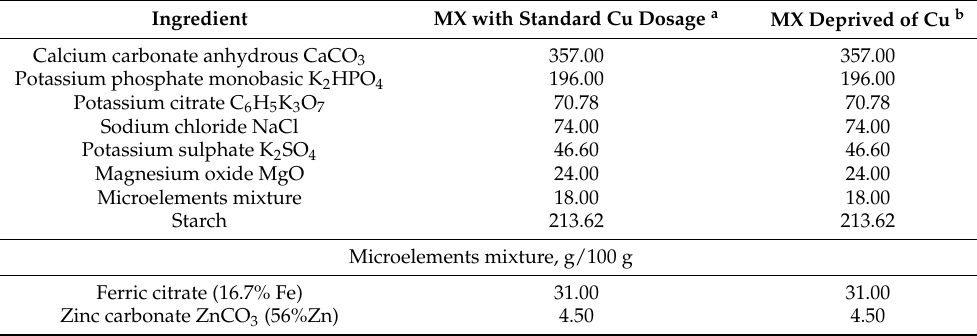
Table 2. Composition of mineral mixtures used in experimental diets, g/kg of